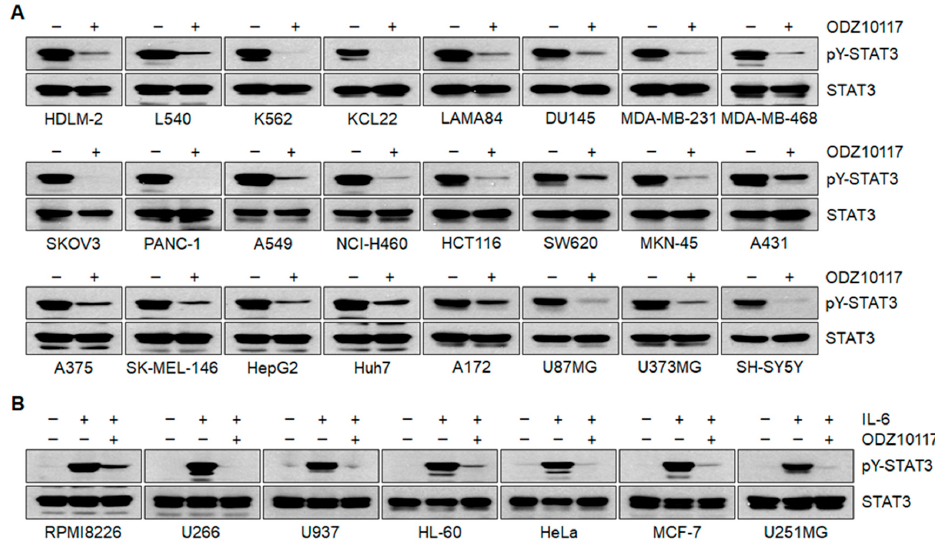
Figure 2. ODZ10117 inhibits tyrosine phosphorylation of STAT3 in various human cancer cell lines. ( A , B ) Various types of human cancer cell lines with STAT3 constitutively activated ( A ) or activated by IL-6-stimulation (20 ng/mL) for 10 min ( B ) were incubated for 24 h with either vehicle (0.1% DMSO) alone or ODZ10117 (40 μ M) and immunoblotting was performed.